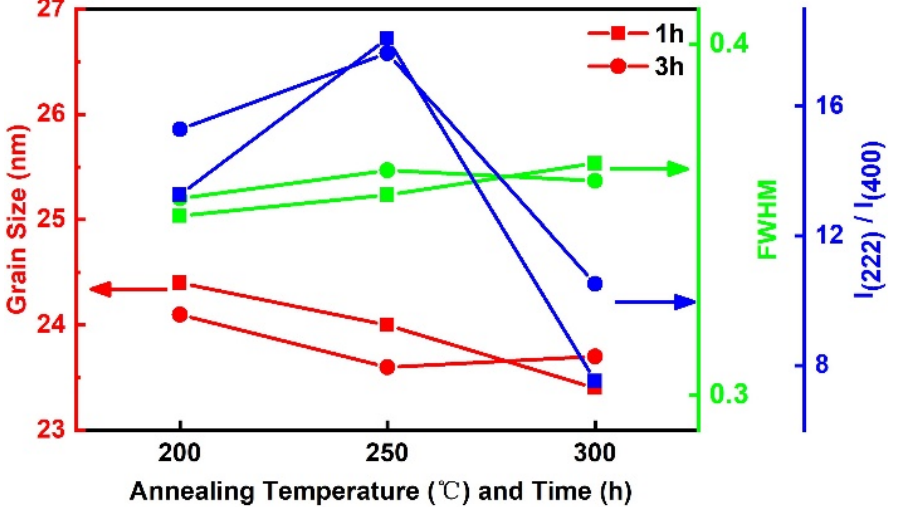
Figure 3. (222)-oriented grain size, diffraction peak half-height width, and relative intensity of (222)/(400) peaks versus annealing temperature and time.